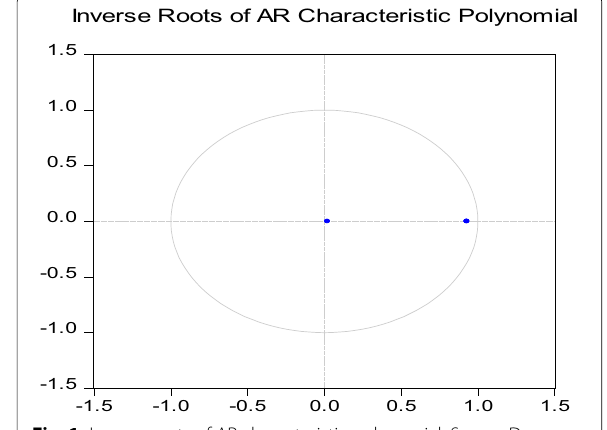
Fig. 1 Inverse roots of AR characteristic polynomial. Source : Done on EViews 10. This graph showed that the model VAR is stationary, because the two roots lie inside the unit circle (under root